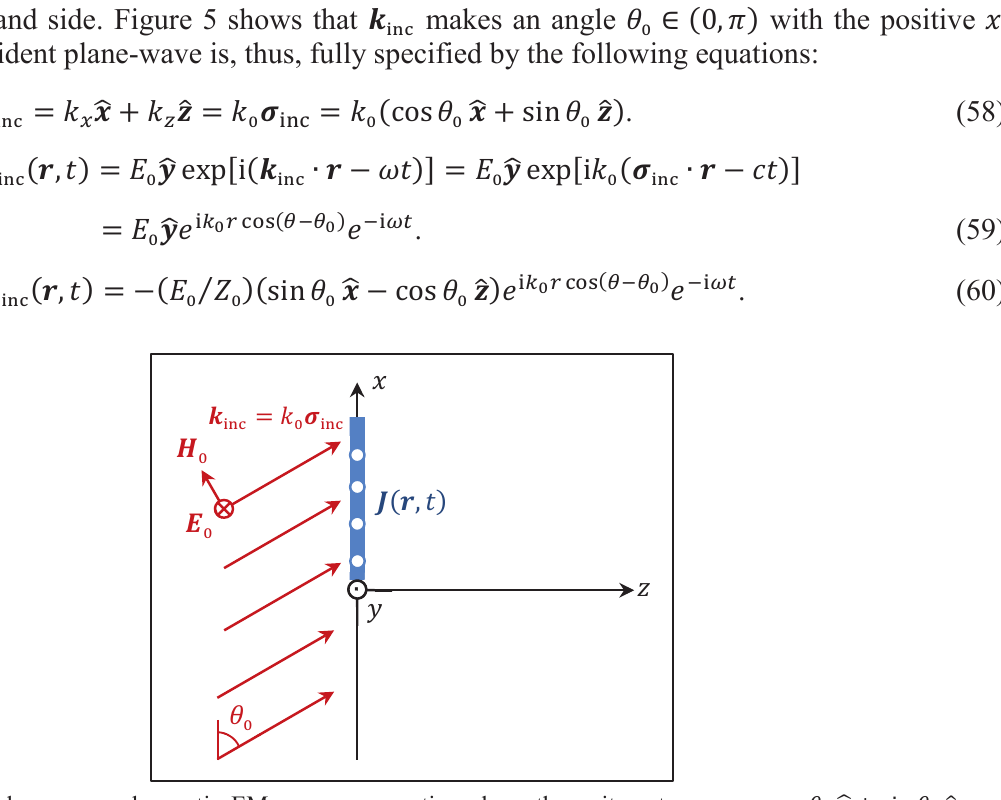
= cos (cid:2016) (cid:2206)(cid:3549) + sin (cid:2016) (cid:2208)(cid:3548) (cid:2868) (cid:2868) (cid:3167)(cid:3172)(cid:3161)